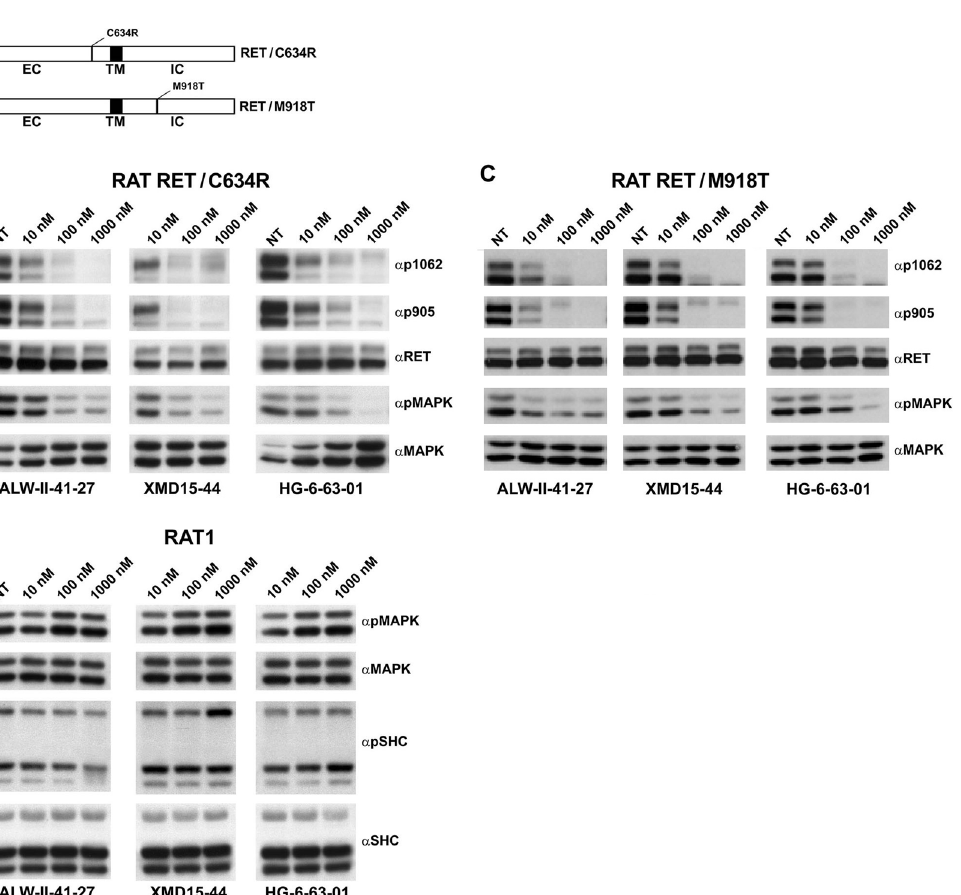
Fig 1. Inhibition of RET/C634R and RET/M918T phosphorylation and downstream signaling by ALW-II-41-27, XMD15-44 and HG-6-63-01. A) Schematic representation of RET/C634R and RET/M918T proteins. EC: extracellular domain; IC: intracellular domain; TM: transmembrane domain. B-D) Serum-starved RAT1 RET/C634R and RAT1 RET/M918T or parental RAT1 cells were treated for 2 hr with the indicated concentrations of ALW-II-41-27, XMD15-44 and HG-6-63-01. 50 μ g of total cell lysates were subjected to immunoblotting with phospho-Y1062 ( α p1062), phospho-Y905 ( α p905) RET antibodies, phospho-MAPK ( α pMAPK) or phospho-SHC ( α pSHC) antibodies. The blots were normalized using anti-RET ( α RET), anti-MAPK ( α MAPK) and anti-SHC ( α SHC) antibodies.